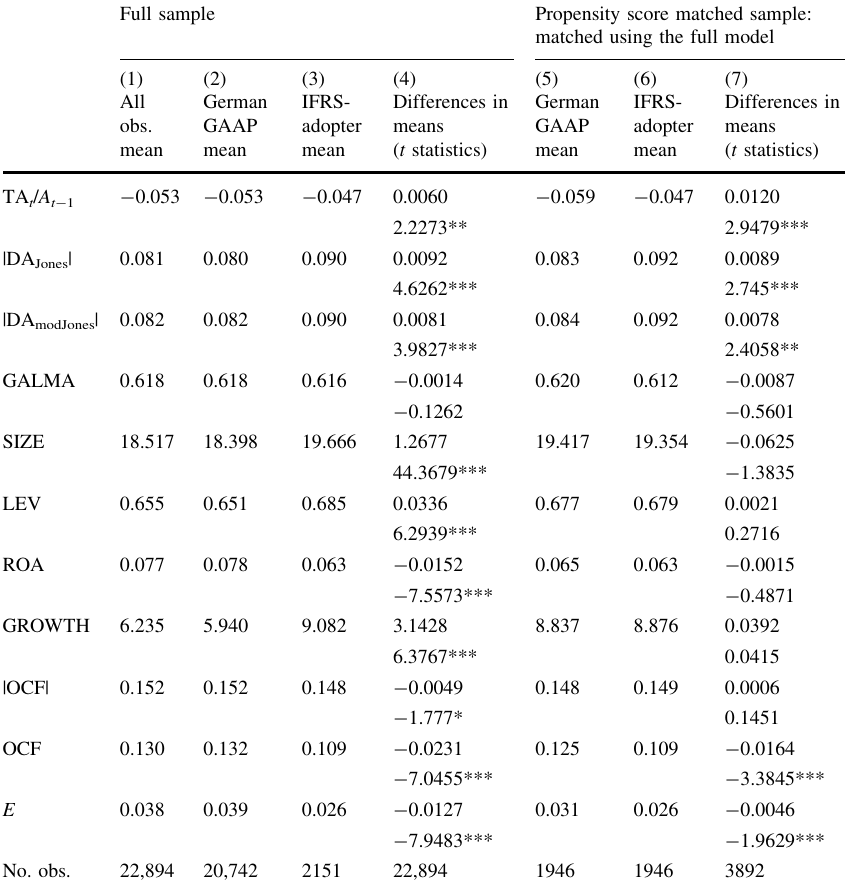
Table 6 Descriptive statistics—results for the full and propensity score matched sample Full